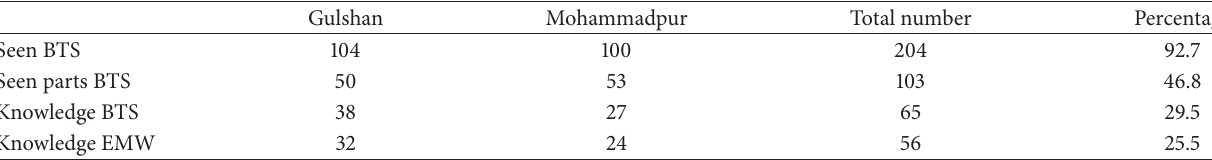
Table 2: Awareness of BTS according to area of residence (𝑛 = 220) .